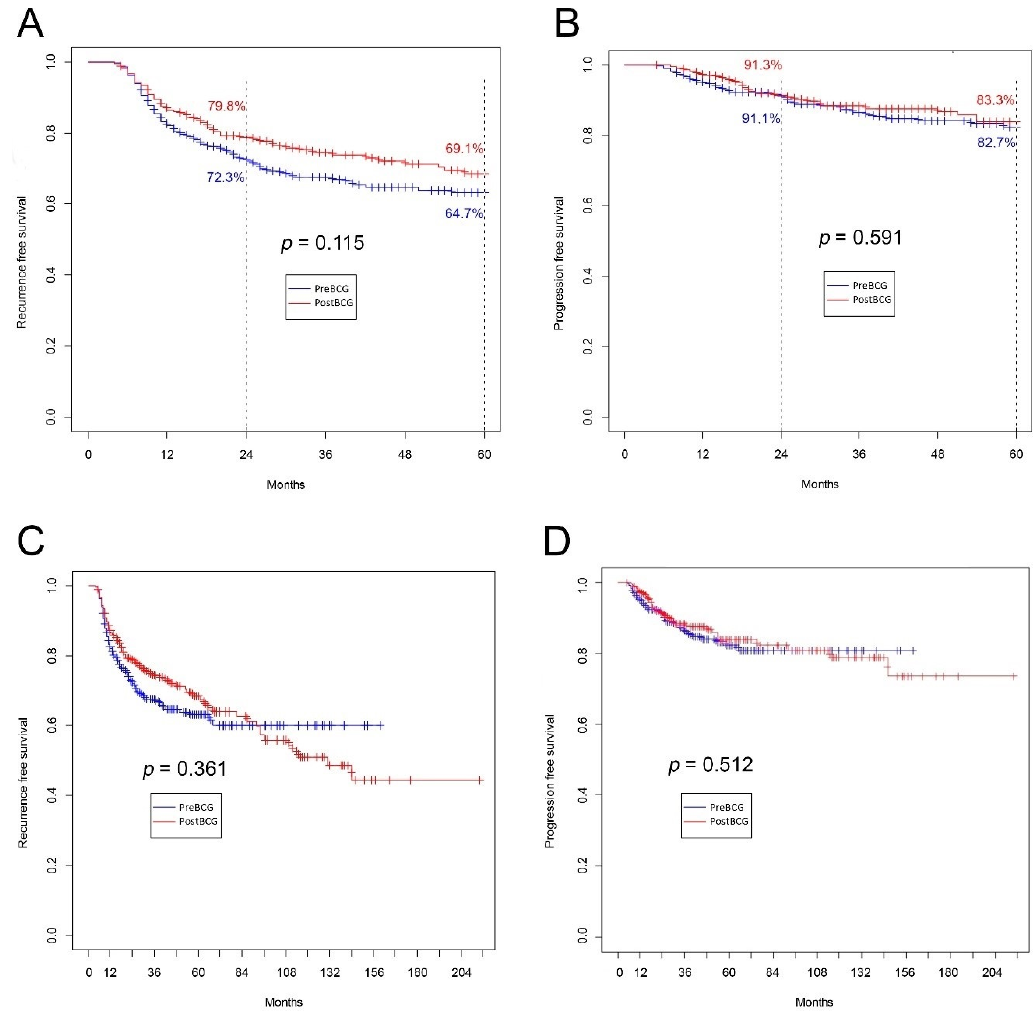
Figure 2. ( A ) Recurrence-free survival for five-year follow-up ( p = 0.115); ( B ) progression-free survival for five-year follow-up ( p = 0.591); ( C ) recurrence-free survival for whole observation period ( p = 0.36); ( D ) progression-free survival for whole observation period ( p = 0.512).